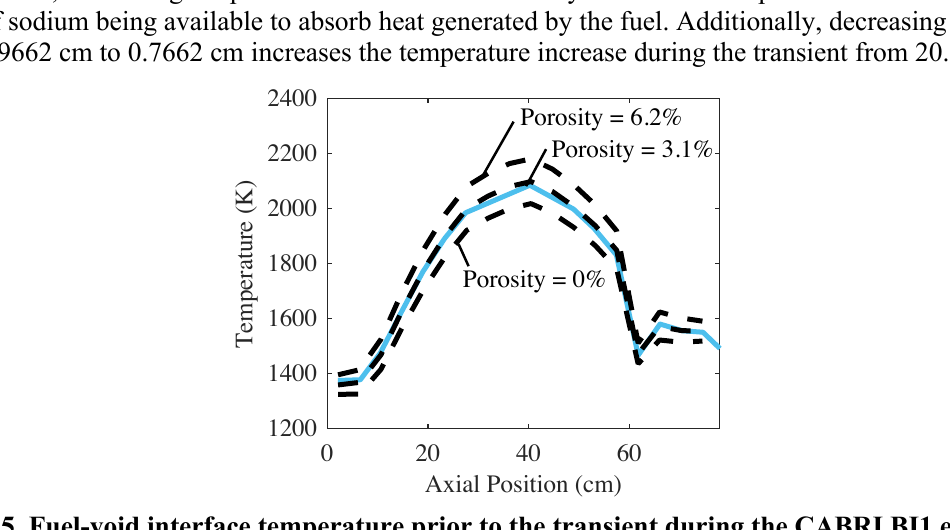
Figure 5. Fuel-void interface temperature prior to the transient during the CABRI BI1 experiment with porosities of 0%, 3.1% and 6.2% and constant mass flow rate. SAS-SFR results by the solid blue curve, and our results are shown by the dashed black